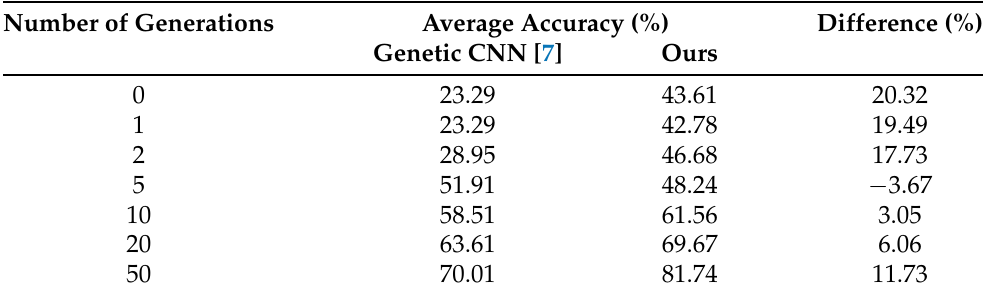
Table 4. Comparison of our algorithm with Genetic CNN